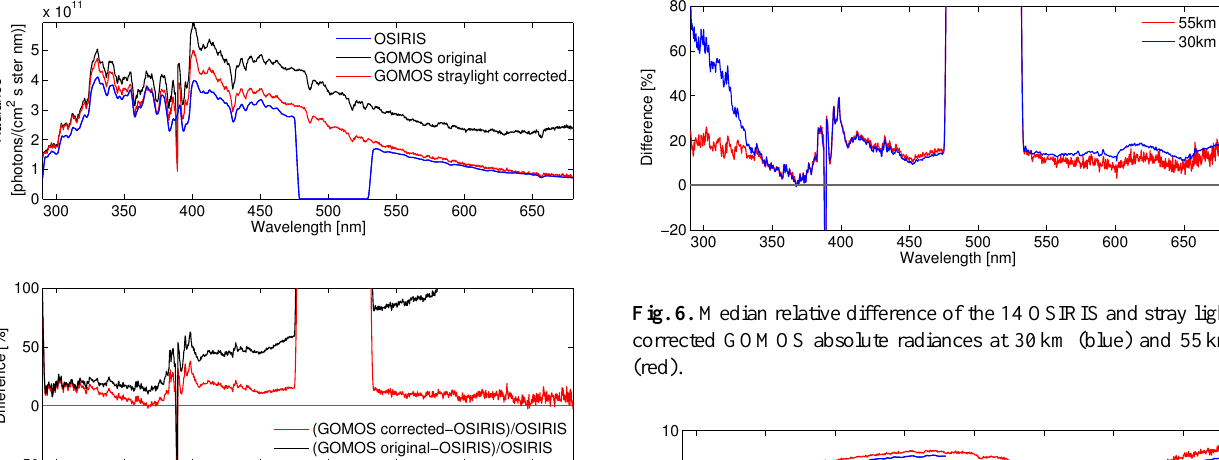
(GOMOS corrected−OSIRIS)/OSIRIS (GOMOS original−OSIRIS)/OSIRIS